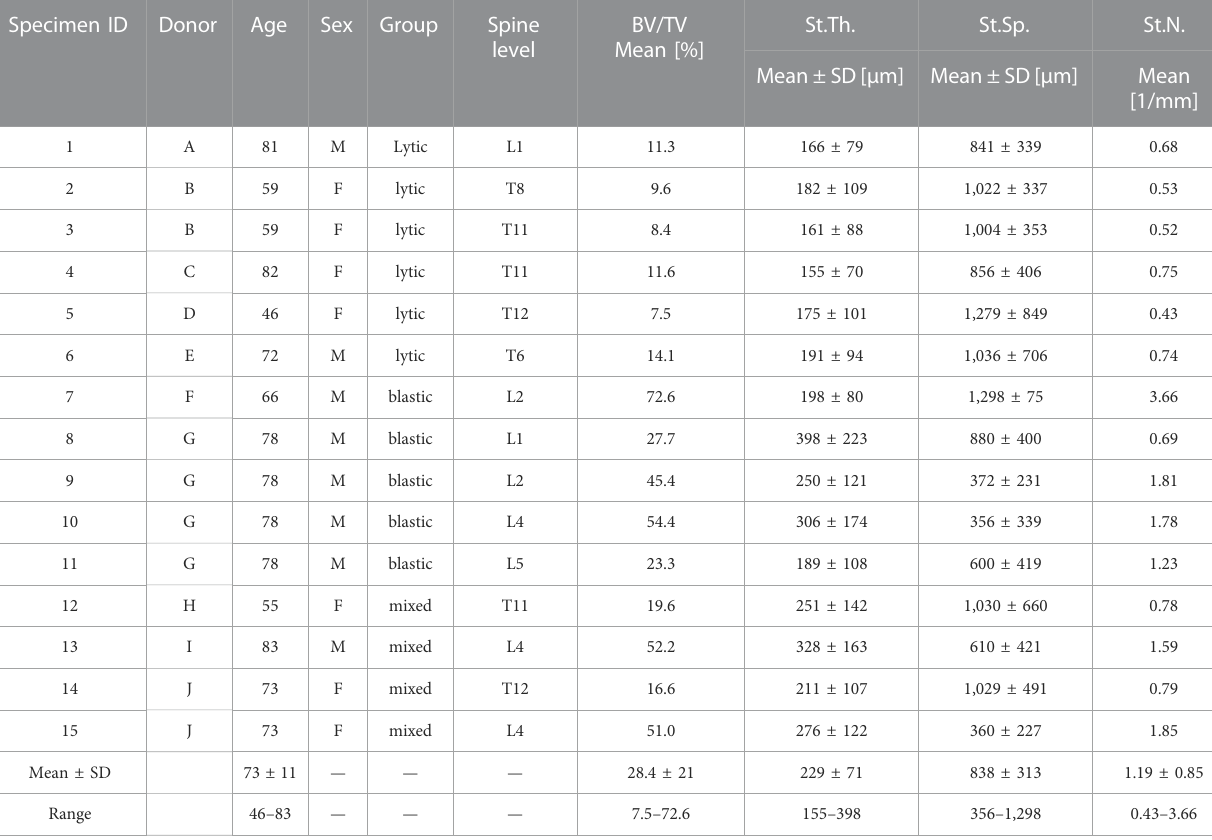
TABLE 1 Main microstructural parameters calculated for each metastatic vertebra. Specimen ID